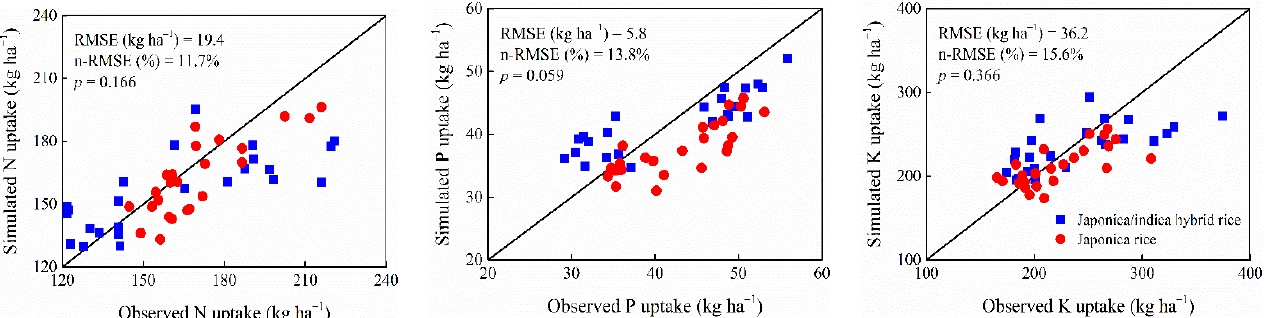
Figure 7. Relationships between the observed nutrient uptake and simulated nutrient uptake for japonica/indica hybrid rice and japonica rice. The observed data are from the field experiments conducted in Jinhua City and Hangzhou City in 2018 and 2019, respectively. The simulated data were derived from the QUEFTS model.